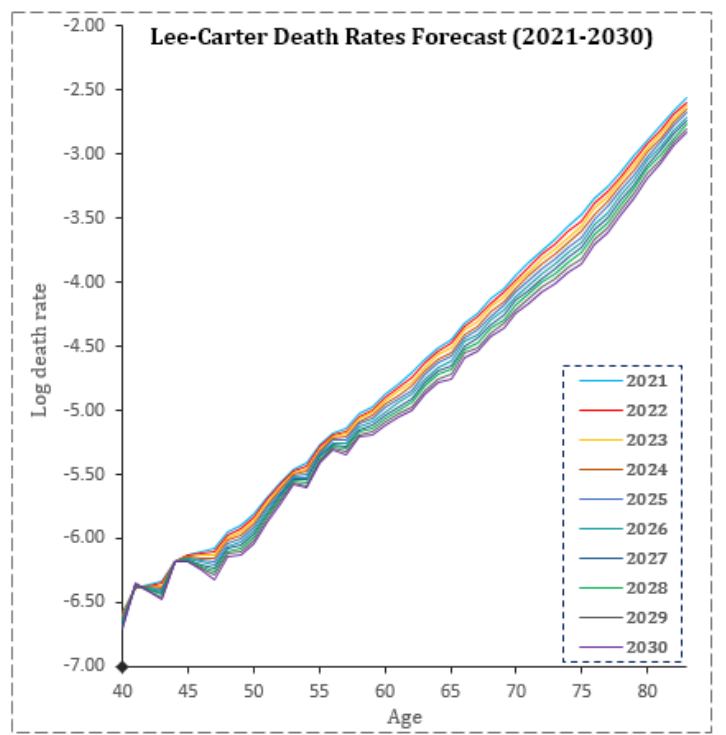
Figure A1. Lee–Carter Rate Forecast for Period